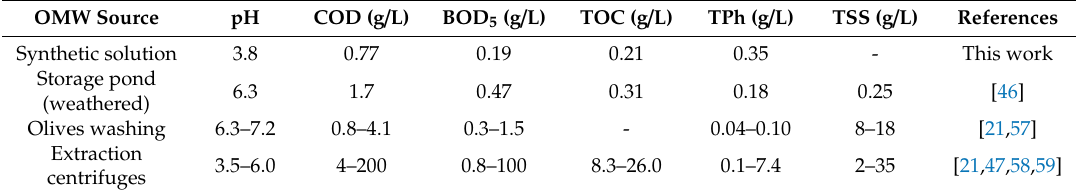
Table 2. Physicochemical characterization of the synthetic e ffl uent; overview of olive mill wastewater (OMW) characteristics from di ff erent sources: storage pond (weathered), olives washing, and olive oil extraction